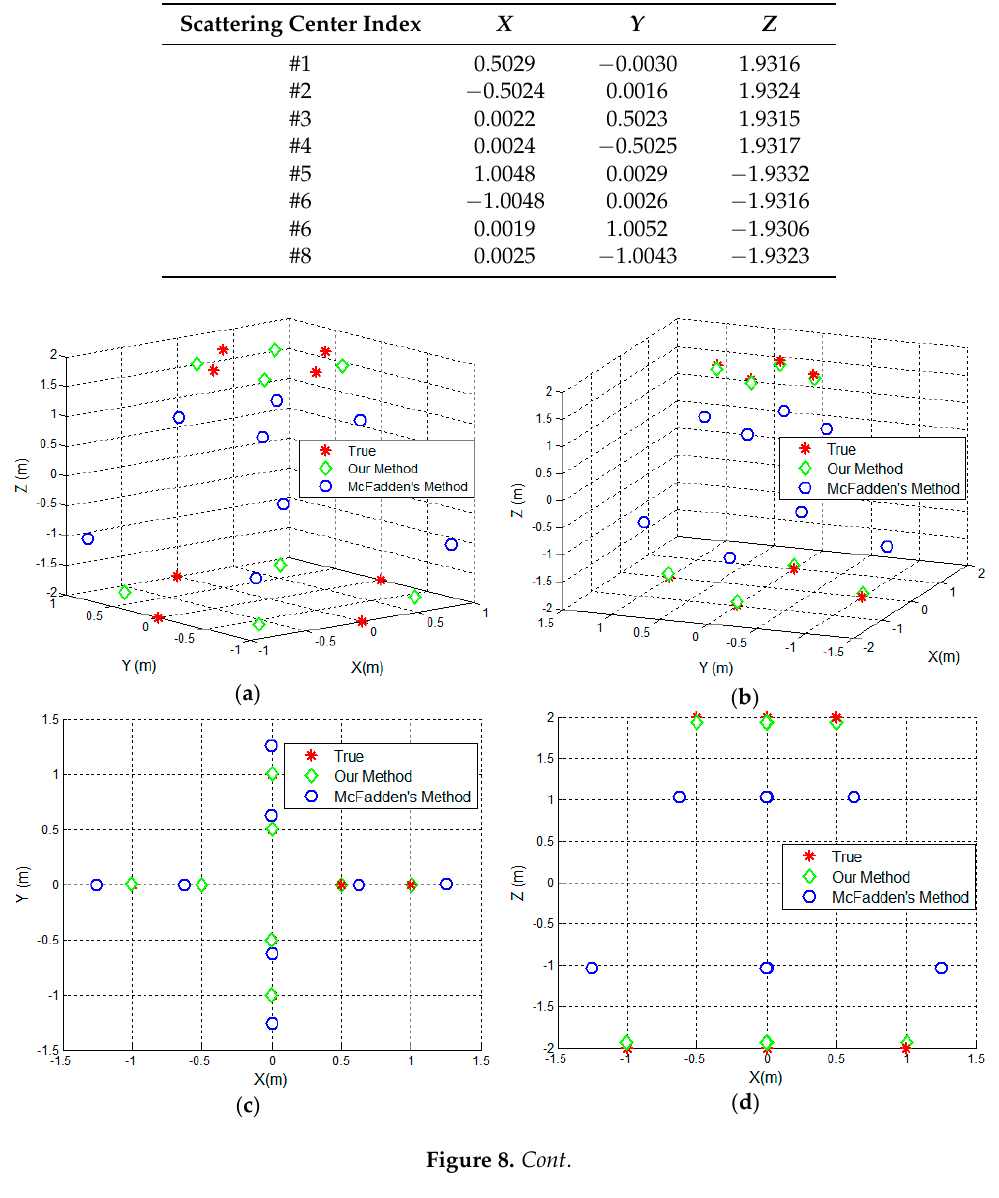
Table 2. Coordinates of reconstructed scattering centers.